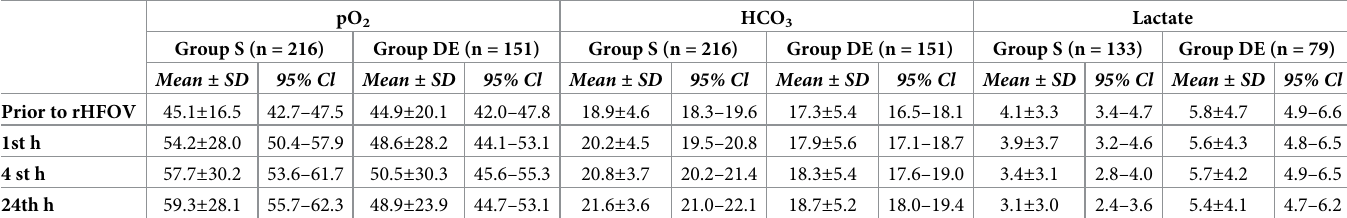
Table 3. pO 2 , HCO 3 and lactate analysis of groups.